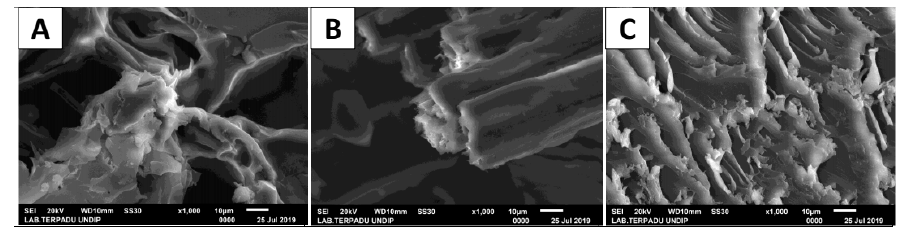
Figure 12. Comparison of 1000X SEM EDX of resin reinforced biomass: ( A ). Coco-husk; ( B ). Hemp; ( C ). Kenaf.